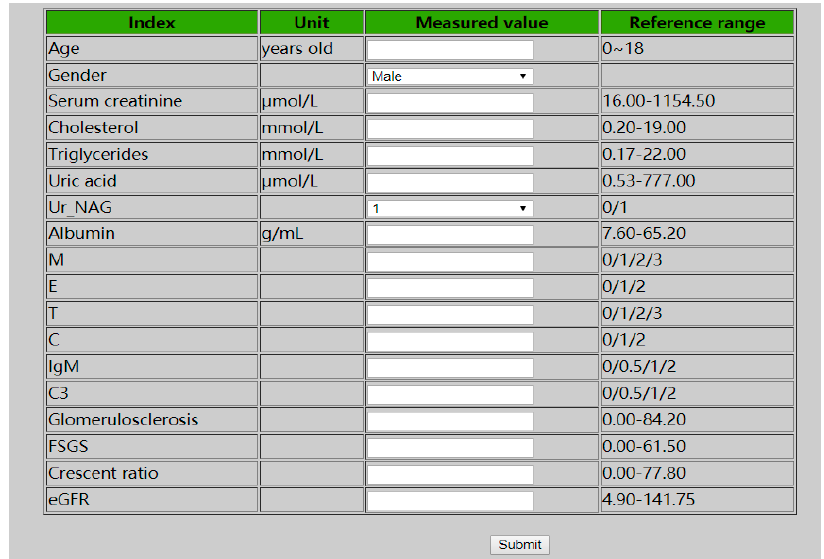
Figure 1. A screenshot of the initial web page of the implemented decision-making system (DMS).